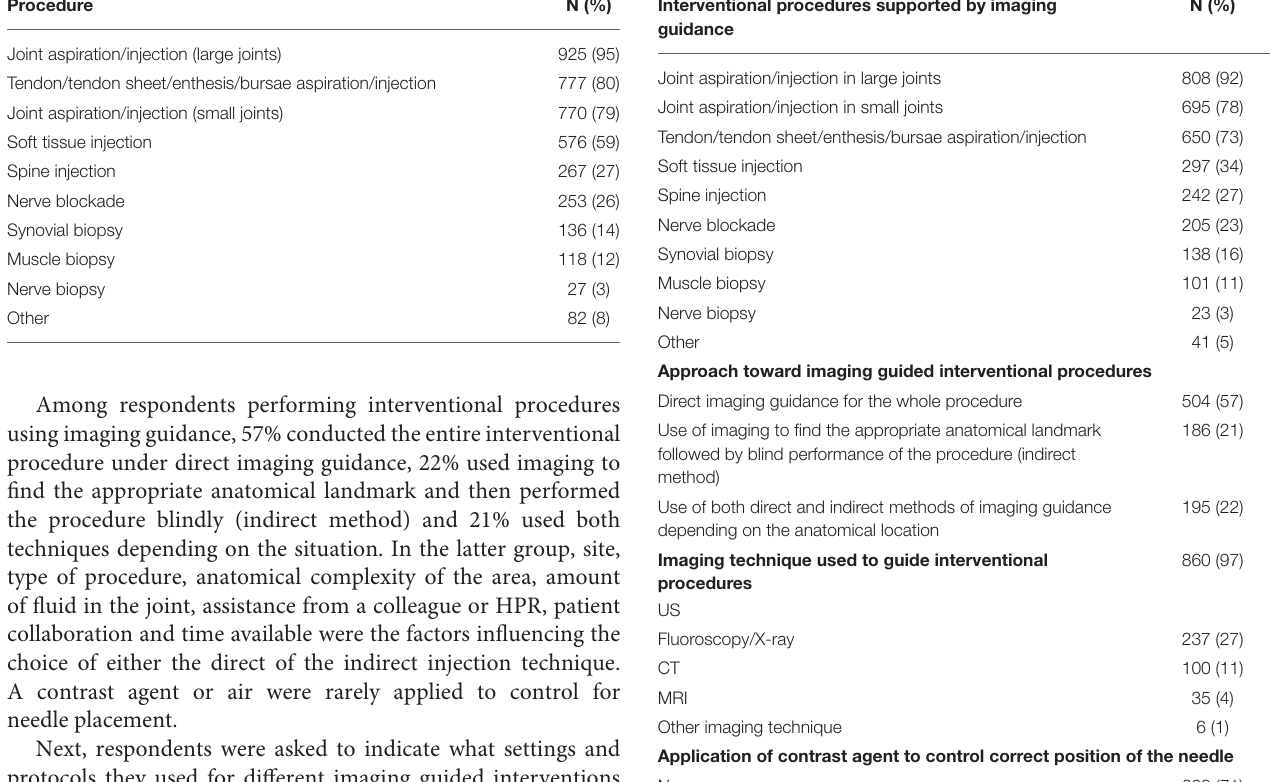
TABLE 3 | Number (percentage) of respondents reporting to apply any of the imaging modalities or techniques for imaging guided interventions as indicated. Interventional procedures supported by imaging